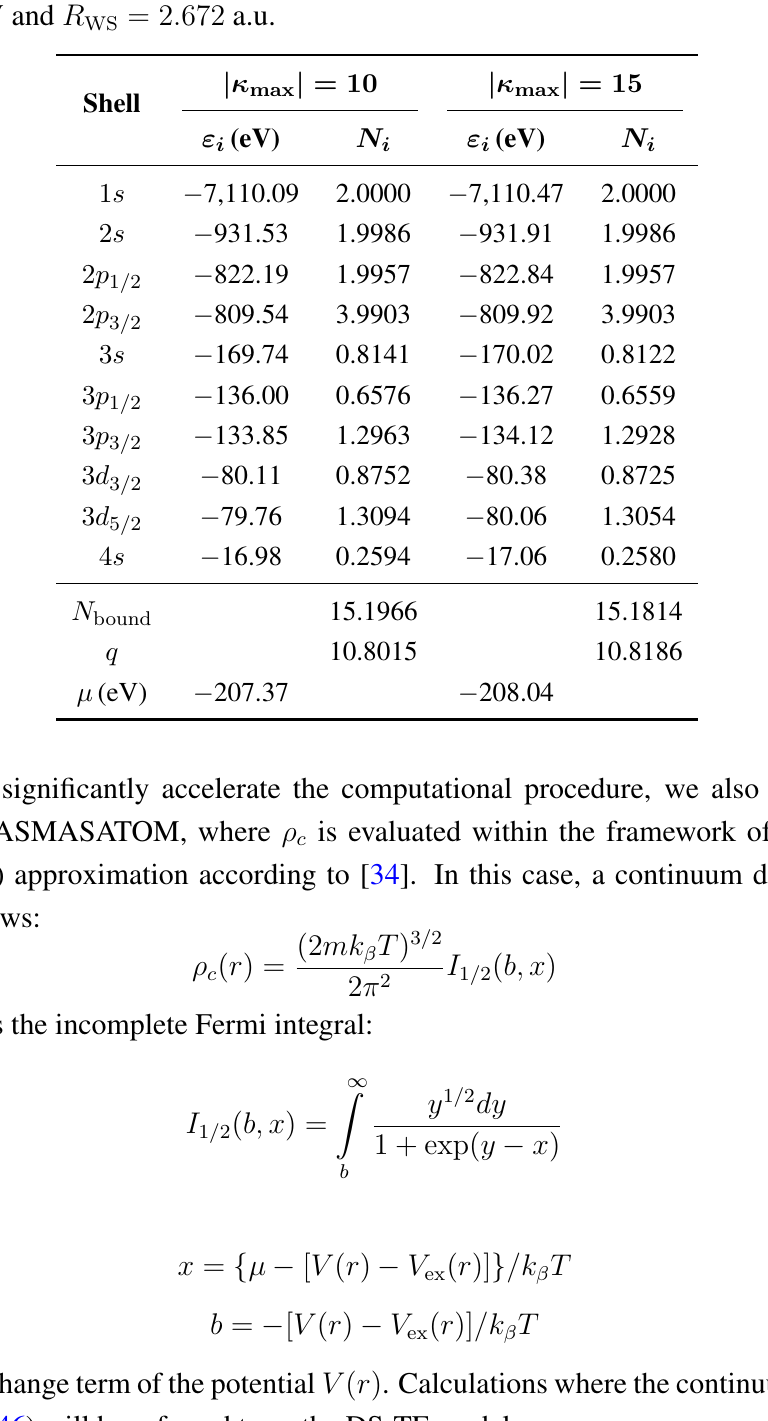
, N (see Equation (53) below), i bound | for the iron ion at max